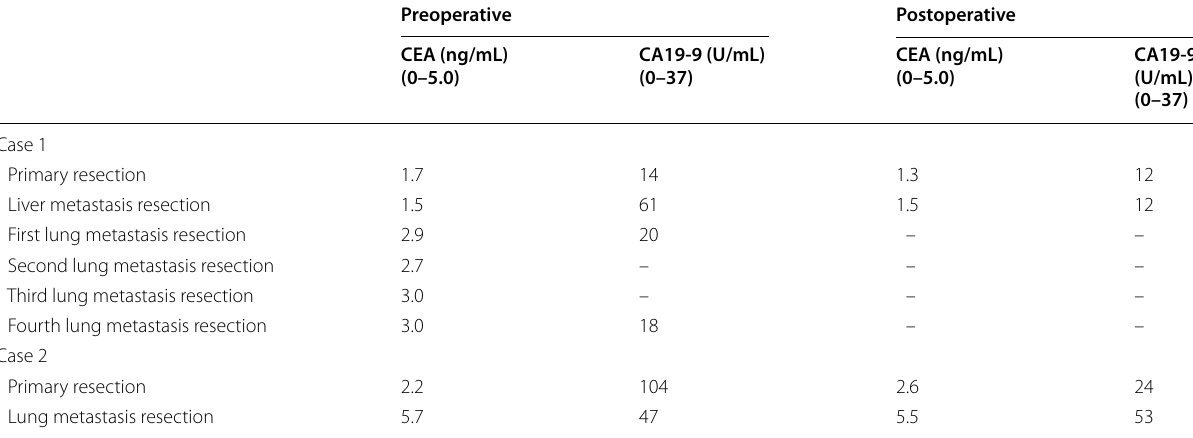
Table 1 Summary of changes in tumor markers